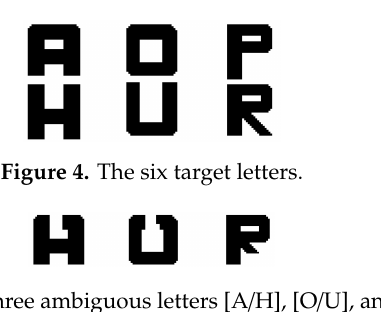
Figure 5. The three ambiguous letters [A/H], [O/U], and [P/R].